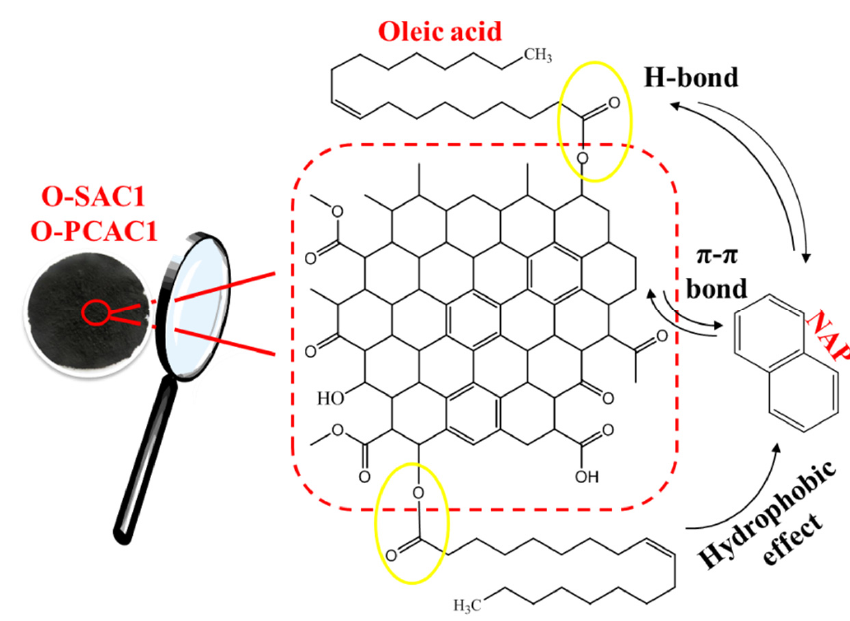
Figure 5. The adsorption mechanism for NAP adsorption on O-SAC1 and